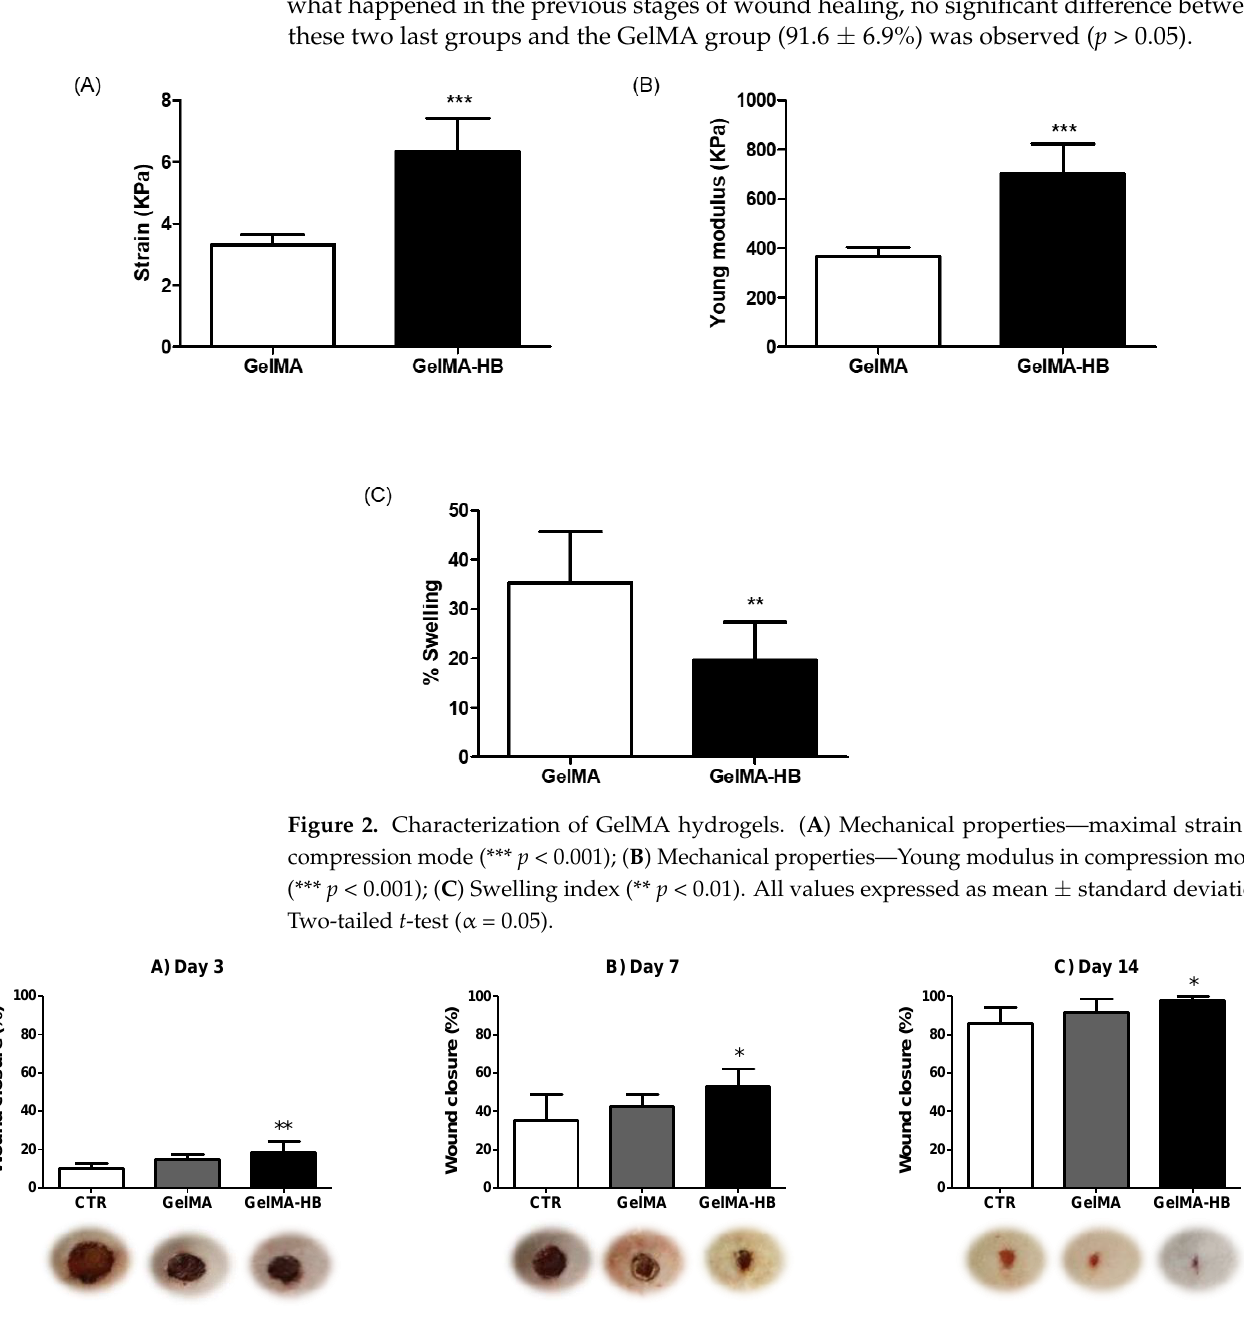
Figure 3. Clinical percentage of wound closure (WCR) over the time course of experimental wound healing on ( A ) day 3, ( B ) day 7 and ( C ) day 14. CTR (untreated control); GelMA (wounds filled with GelMA); GelMA-HB (wound filled with GelMA containing 2% ethanolic extract of H. bracteatus ). Representative images of wounds from each experimental group are presented at the bottom of the figure. All groups exhibited a significant increase in PWC over time ( p < 0.001). Significant differences in comparison with CTR group were expressed as: * p < 0.05 and ** p < 0.01 (two-way ANOVA, followed by Tukey ’ s multiple comparisons test).